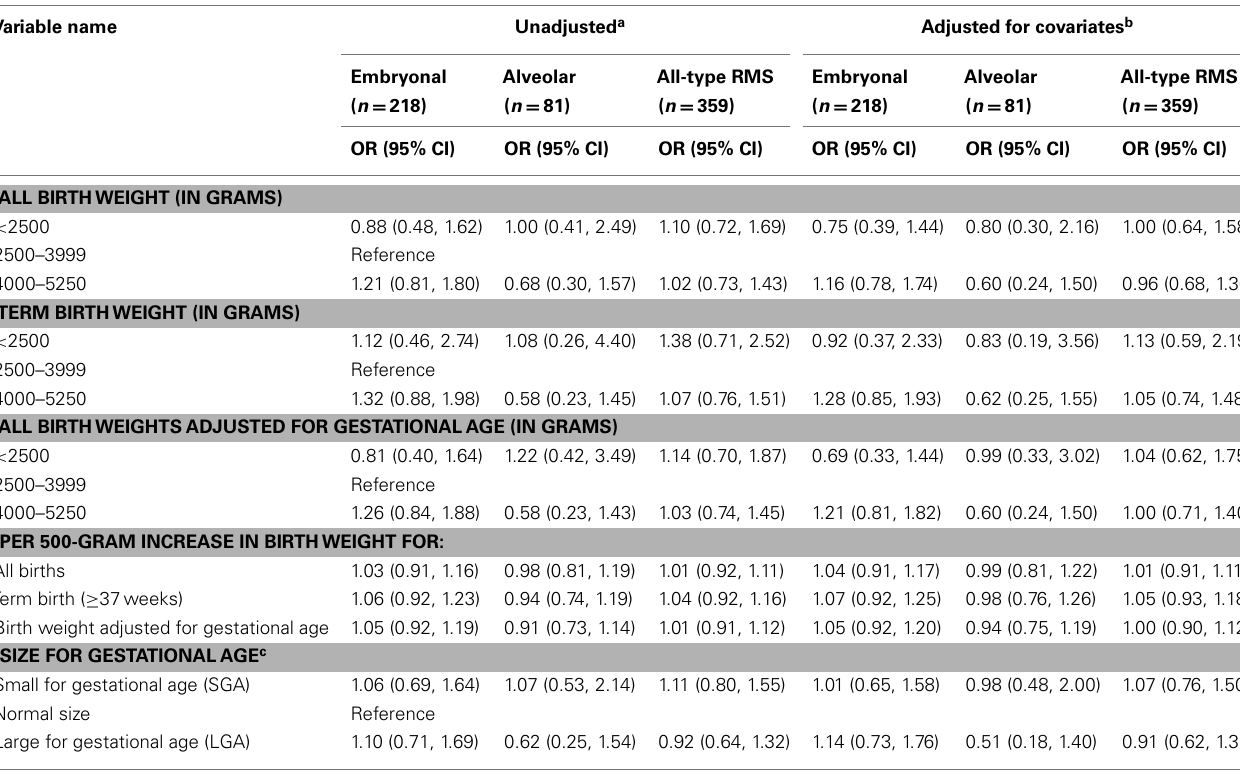
Table 2 | Unadjusted and adjusted logistic regression outcomes for birth weight and size at gestational